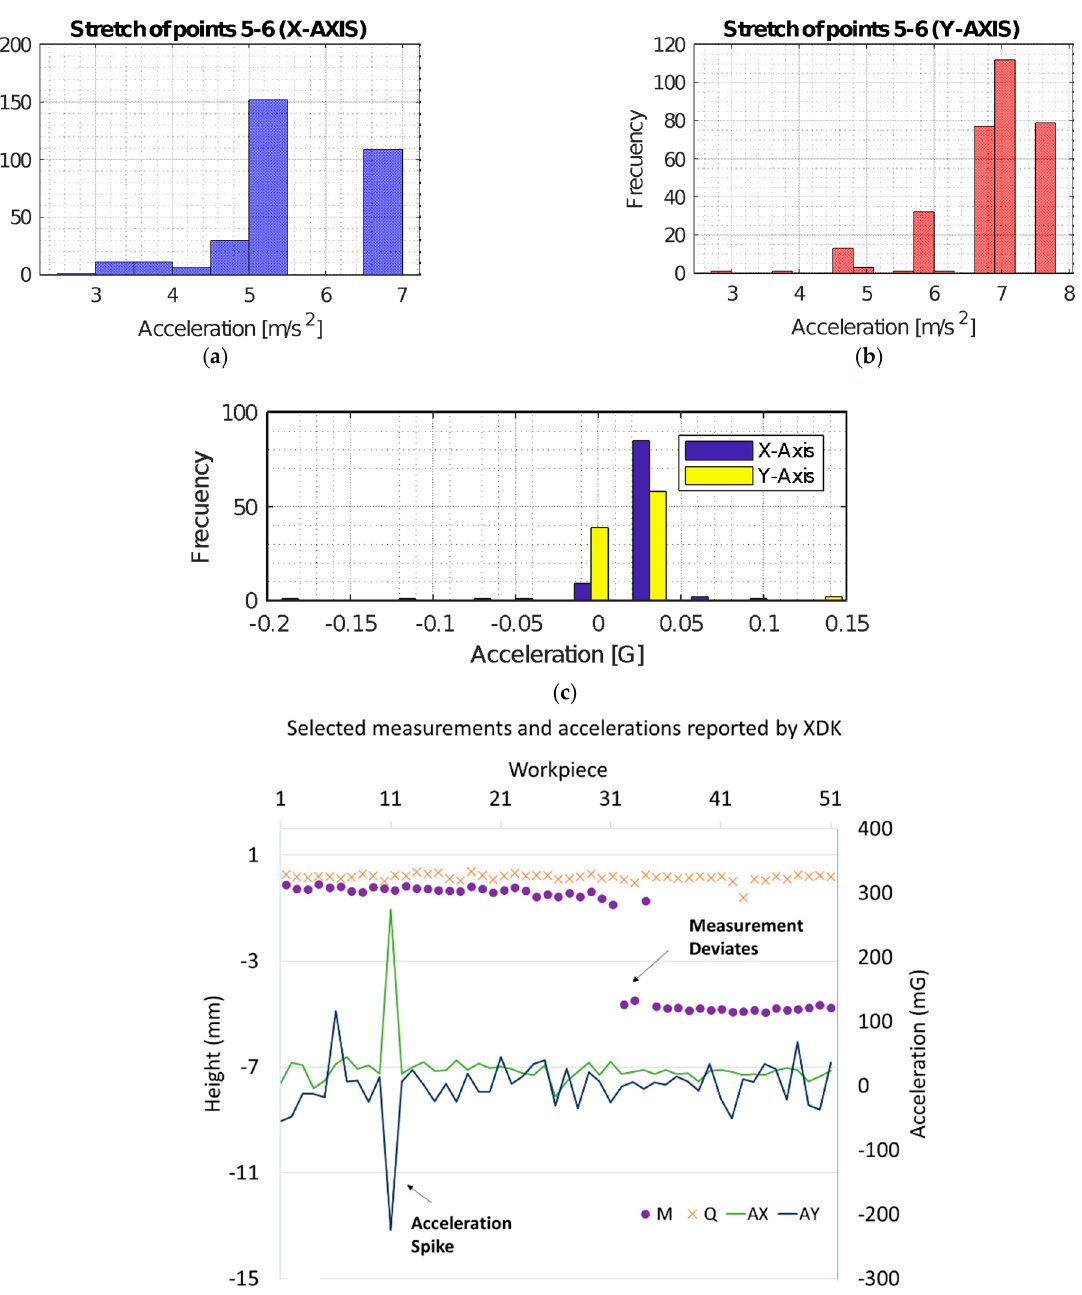
Figure 16. ( a , b ) Histogram of acceleration of X and Y axes of the positioning system. ( c ) Histogram of accelerations reported by the XDK sensor. ( d ) Part deviation measured after machine was subject to shock.